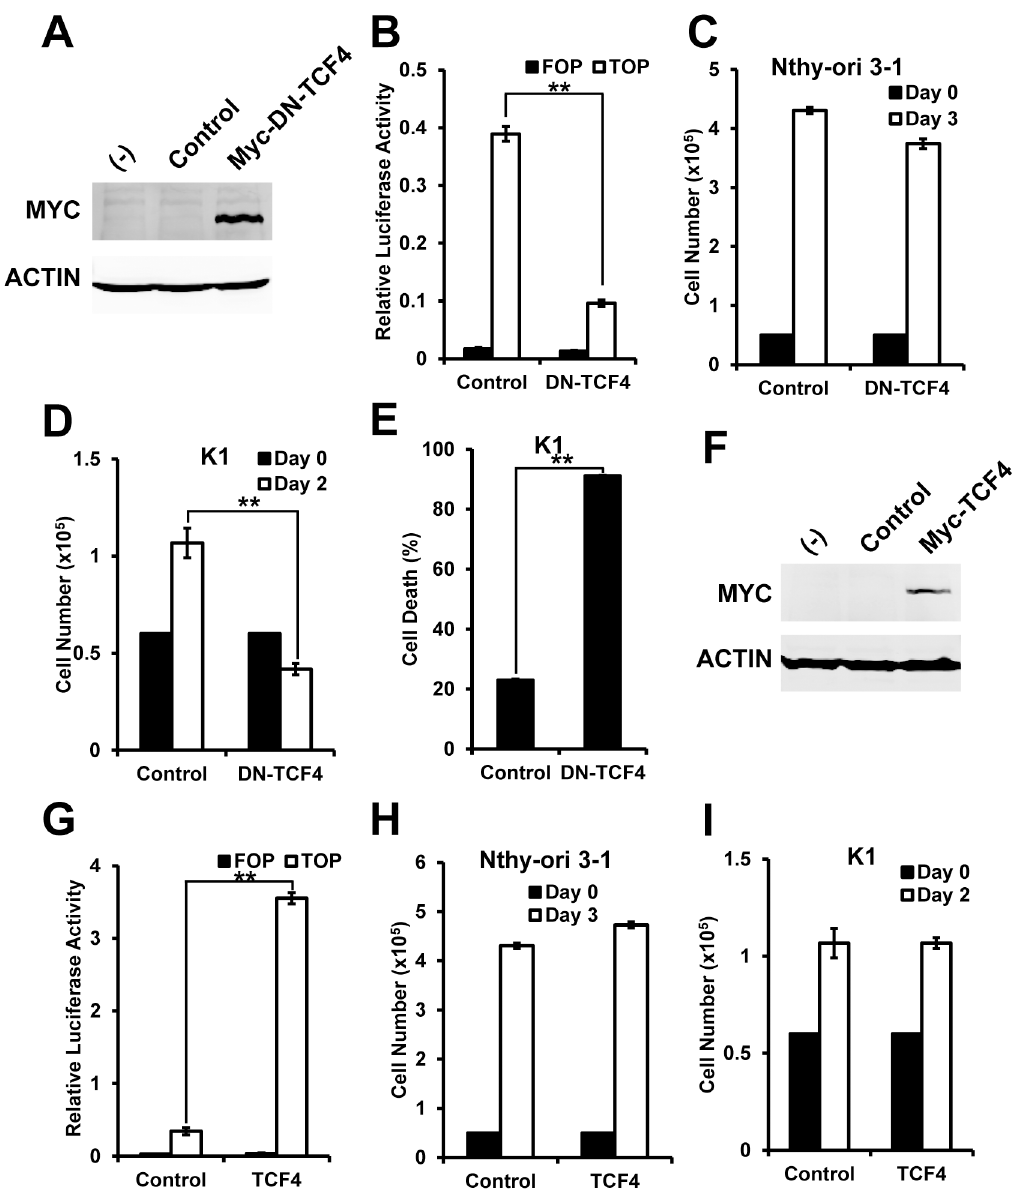
Fig 2. K1 cells depend on Wnt signaling for growth and survival. (A) Immuno blot showed overexpression of DN-TCF4. Actin serves as a loadingcontrol; (B) TOP-Flash reporter showedoverexpression of DN-TCF4